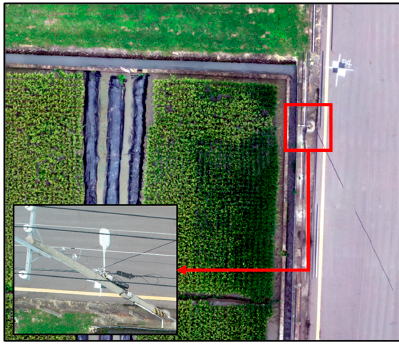
Figure 15. Street light causing over-growing PH and preventing from blooming in CP-I in the first crop season. Sensors 2020 , 20 , x FOR PEER REVIEW